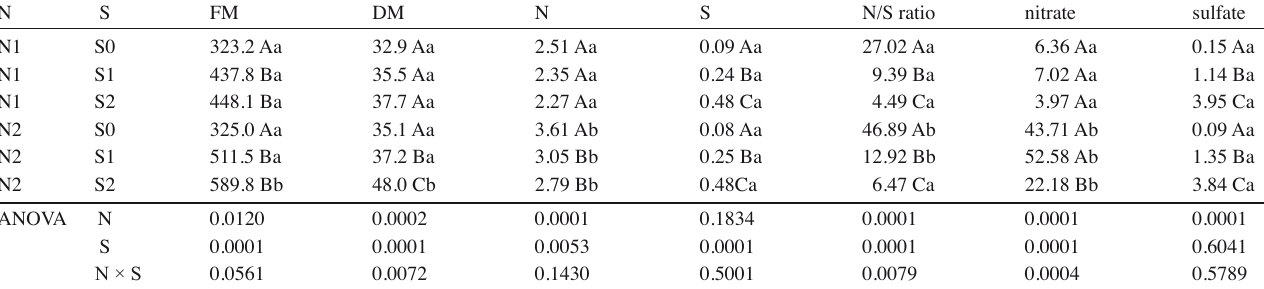
Tab. 2: The concentration of N, S, N/S ratio, nitrate, and sulfate, fresh matter and dry matter in response to varied nitrogen and sulfur